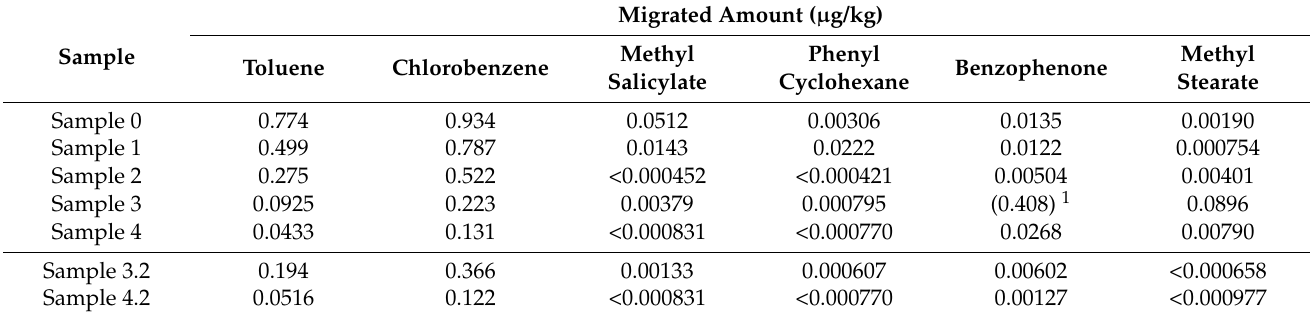
Table 6. Migrated amounts of the surrogates and styrene into the gas phase from yogurt cups after storage for 10 days at 40 ◦ C (pre-storage time for Samples 3.2 and 4.2 is 14 months; pre-storage for all other samples is 7 months). Spiked values normalized to 3